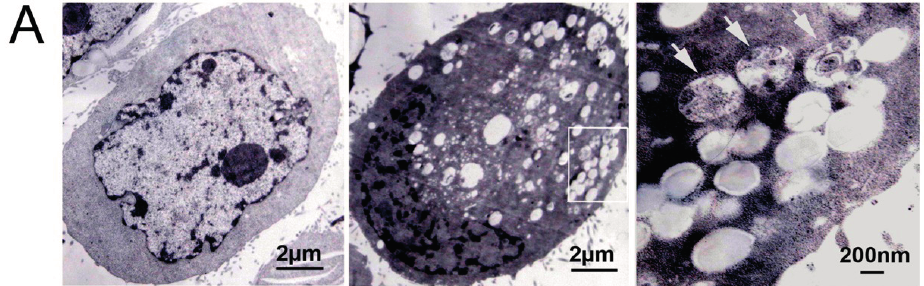
Figure 2. GRb1 inhibited OGD-induced autophagic death in SH-SY5Y cells. ( A ) Images acquired by transmission electron microscope. Compared with control group, many autophagic vacuoles formed in the cytoplasm of SH-SY5Y cells stressed by OGD at recovery 24 h. Vacuoles containing organelles were indicated by arrows; ( B ) Images of acridine orange (AO) staining under fluorescence microscope. Many red spots formed in the cytoplasm of SH-SY5Y cells, which were attenuated by administration of GRb1 either at concentration of 1.0 or 10 µmol/L; ( C ) Flow cytometric assay of AO staining; ( D ) Images of Monodansylcadaverine (MDC) staining. The fluo-density in the OGD group was higher than that in the control group, but it was mitigated effectively by 1.0 and 10 µmol/L GRb1; ( E ) Western blotting analysis of the expression of autophagy hallmark proteins Beclin1 and LC3II at 12 h recovery; ( F ) Western blotting analysis of the expression of Beclin1 and LC3II at recovery 24 h. The protein levels of Beclin1 and LC3II increased significantly at 12 and 24 h recovery following OGD treatments, when compared with those in the control group. However, they were both suppressed by treatment with GRb1. Moreover, the inhibitory effect of GRb1 at 10 µmol/L was stronger than that at 1.0 µmol/L. * p < 0.01 versus OGD group; # p < 0.05 versus OGD group. Each experiment was performed four